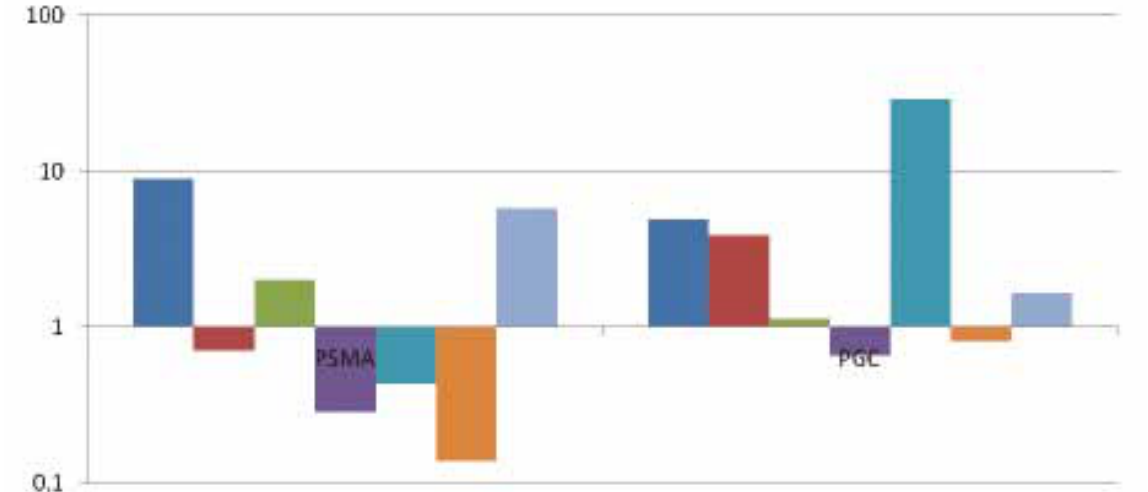
Figure 3. Quantitative expression of PsMA and PgC in prostatic tissue from patients with low risk